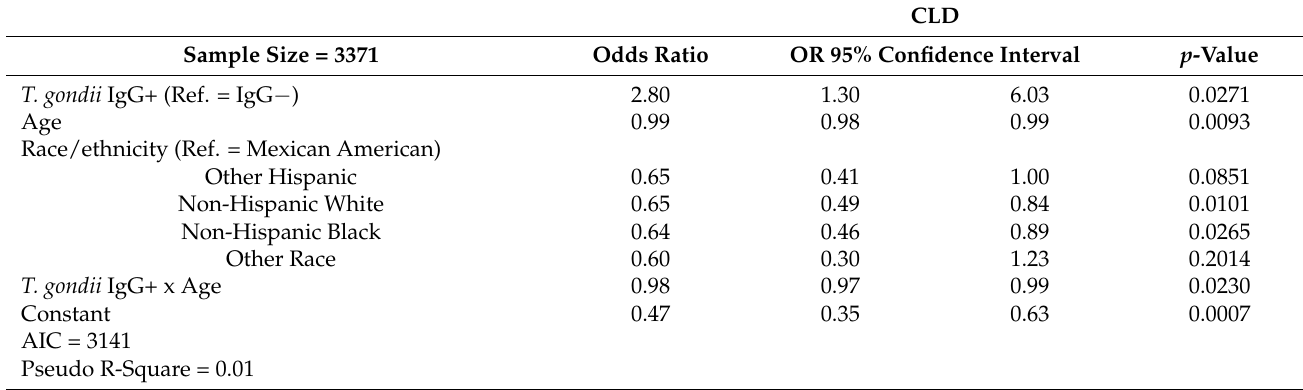
Table 6. Results of binomial logistic regression for CLD on T. gondii (IgG+/IgG − )—adjusted for the demographic factors (excluding gender and